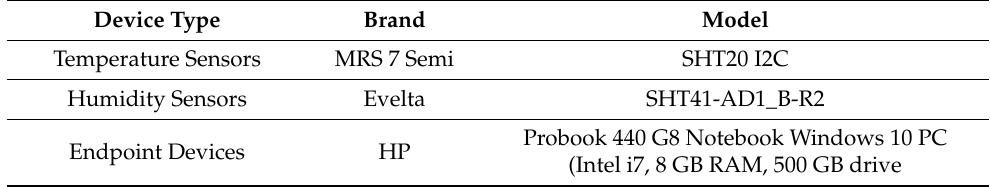
Figure 5. IoT nodes’ communication for temperature and humidity sensors. Table 7. presents the working environment and setup for the research.